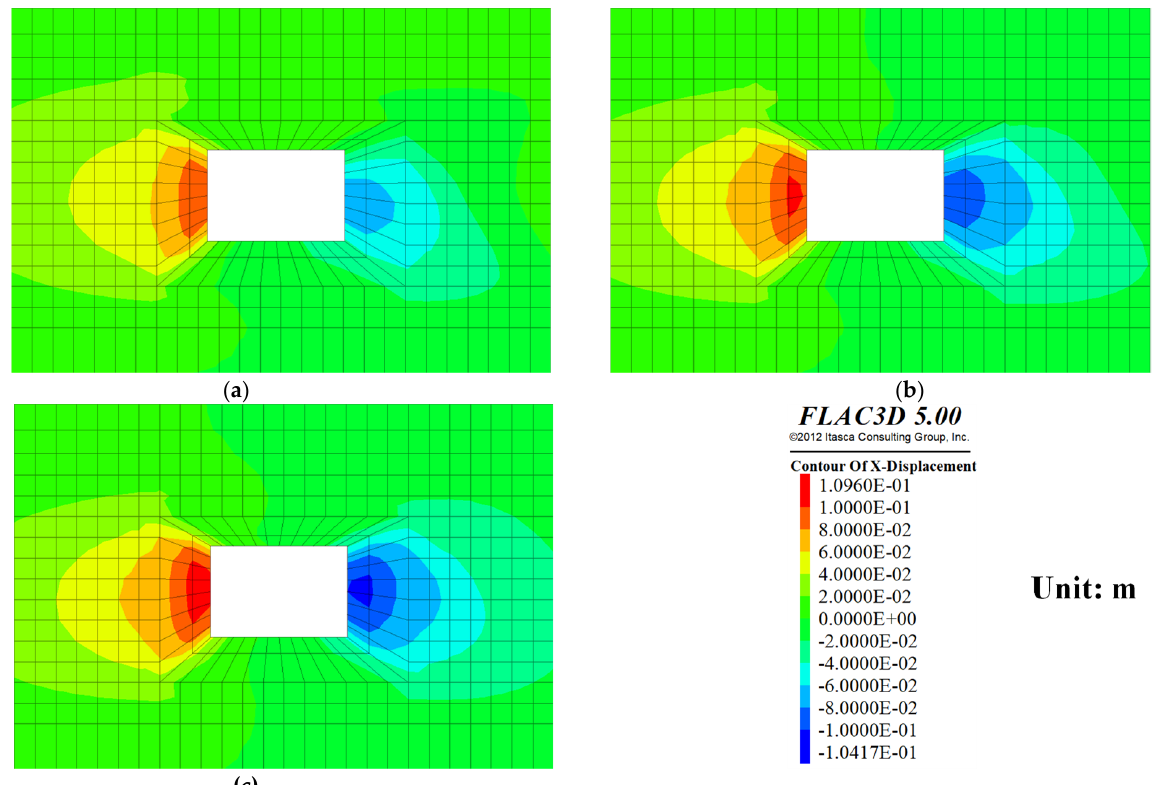
Figure 18. The horizontal displacement distribution of the two sides of the different yield pillar widths during the excavation: ( a ) model 4 m; ( b ) model 6 m; ( c ) model 8 m.